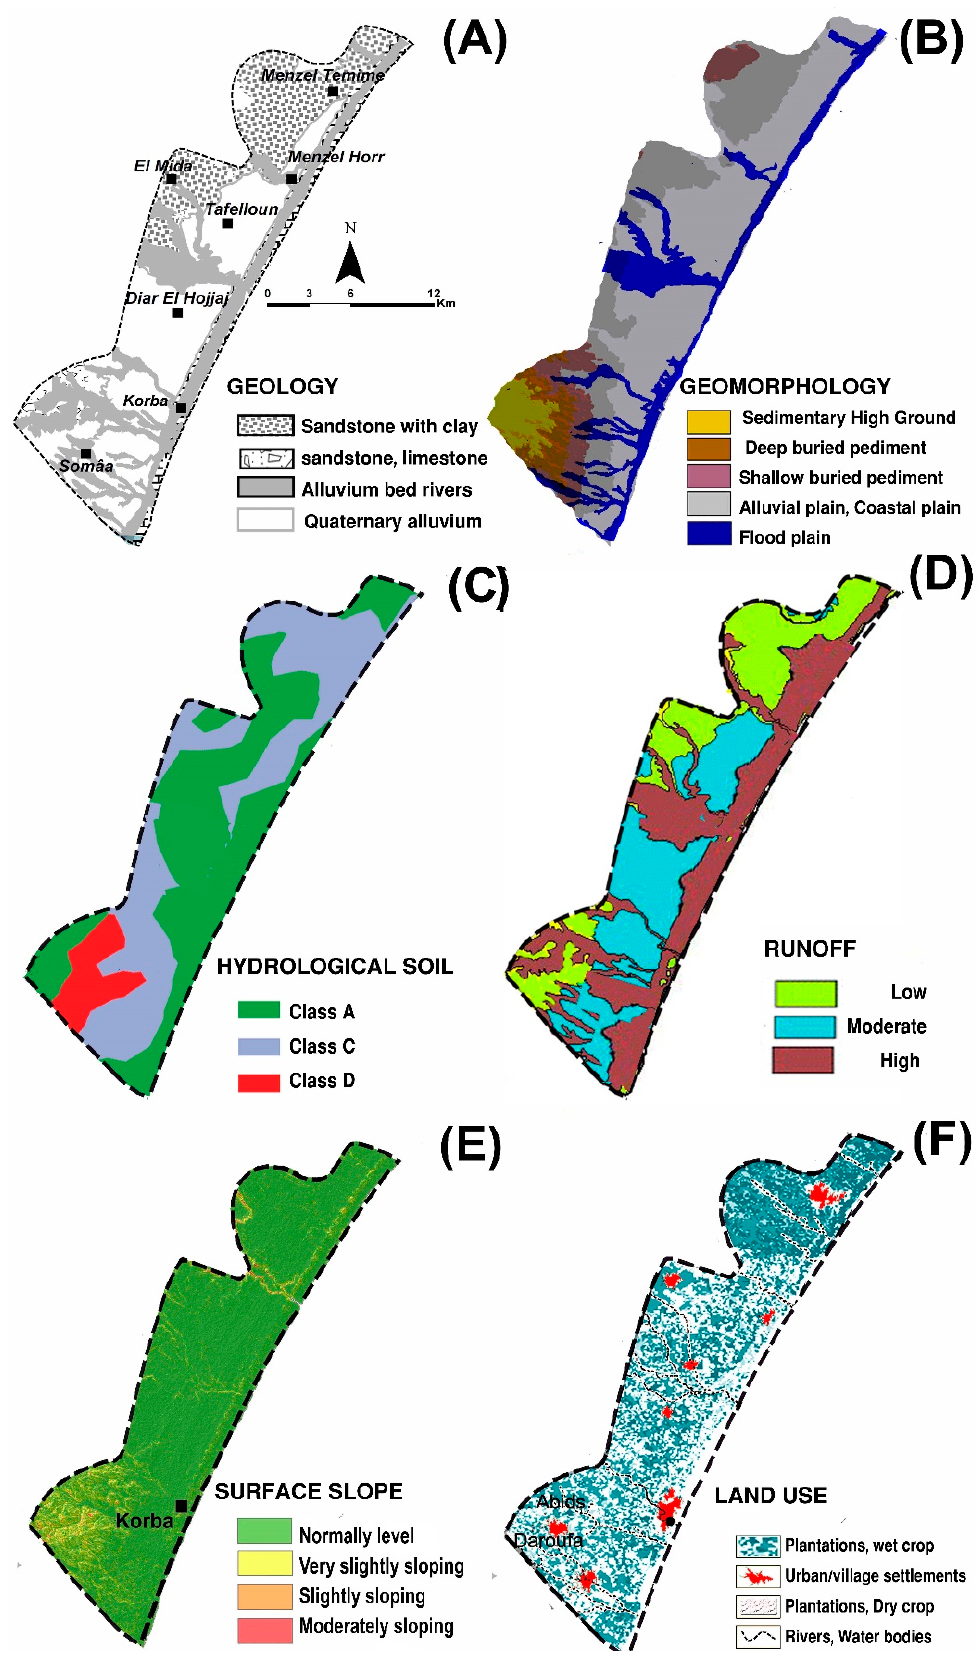
Figure 6. The six parameters used to identify suitable locations for GW artificial recharge.